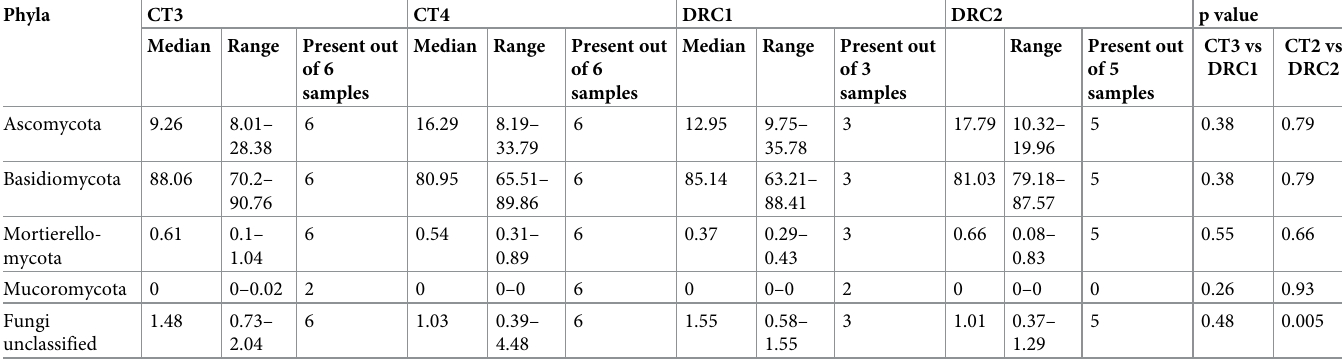
Table 2. Comparison of the median abundance (%) of fungal phyla in the gut mycobiomes of diabetic rats showing retinal changes after 1 (DRC1, n = 3) and 2 months (DRC2, n = 5) with control rats after 3 (CT3, n = 6) and 4 months (CT4, n = 6)